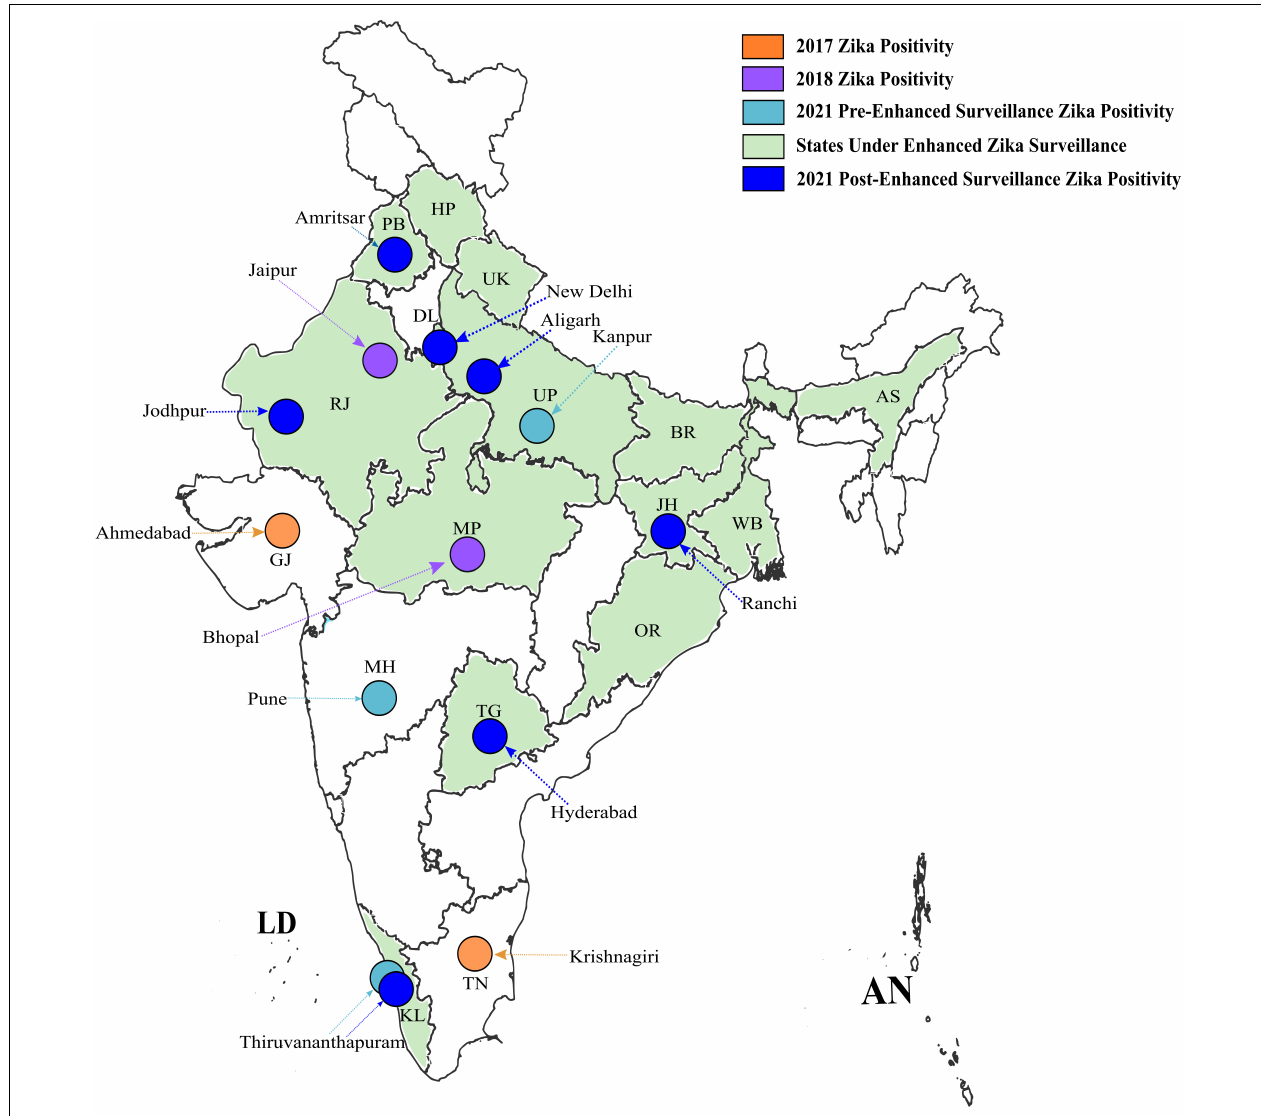
FIGURE 1 | Geographical distribution of Zika positive cases in India: ZIKV positivity of reported during the earlier and current ZIKV surveillances in different states and UT of India. ZIKV positivity observed during different surveillance are marked in different colors. The bottom of the figure denotes the abbreviation of the states marked on the map. The outline of the Indian map was approved from survey of India and edited in Inkscape version